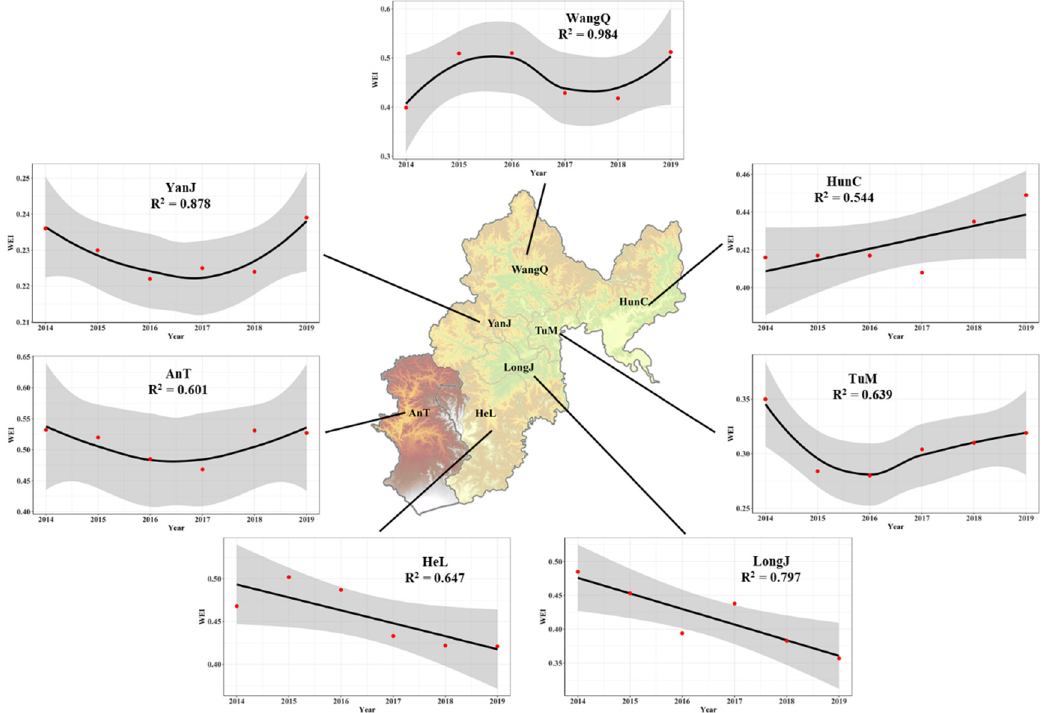
Figure 15. The trend of the water resource utilization efficiency index (WEI) from 2014 to 2019.